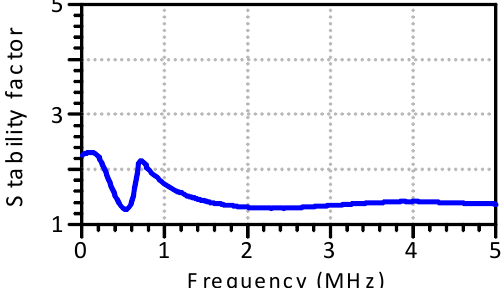
Figure 6: Rollet’s factor of the NGD device shown in Figure 2.